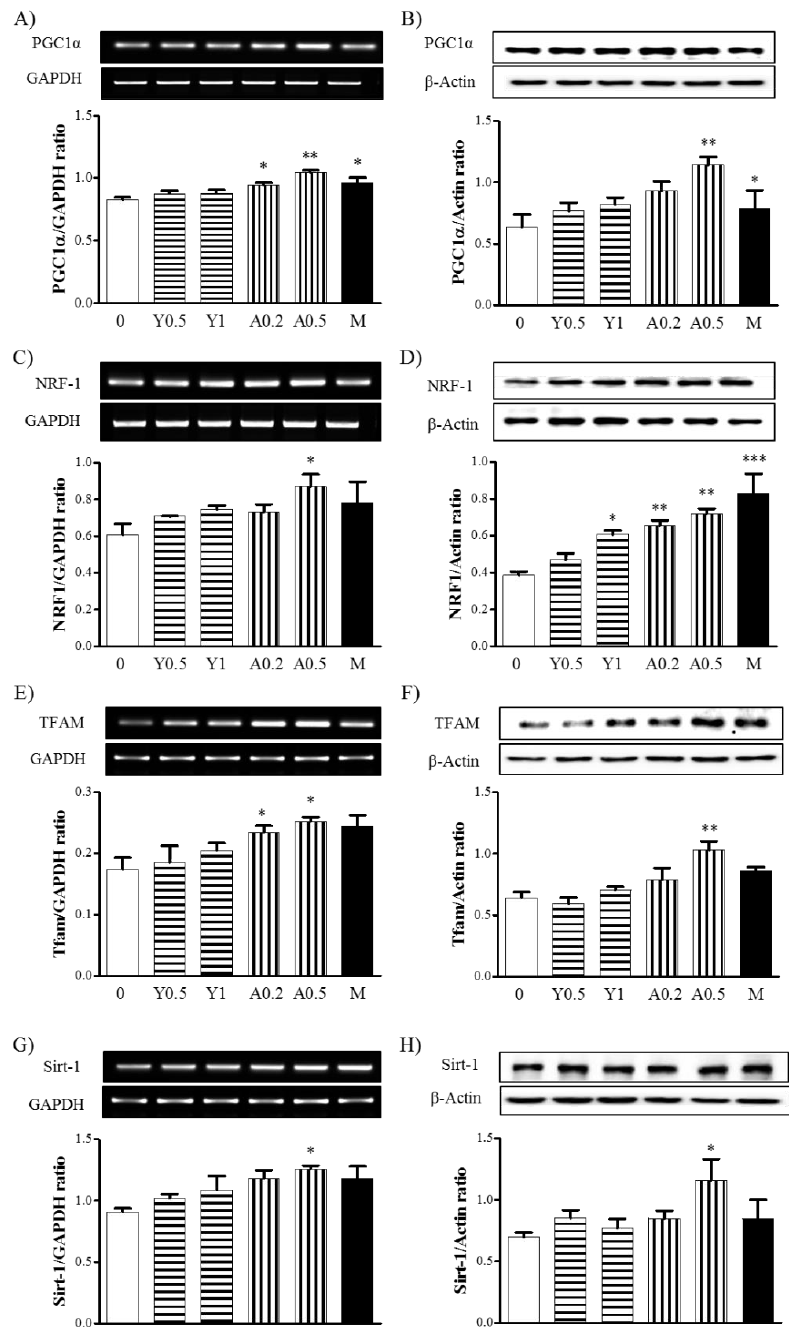
Figure 2. Effects of yam extract and allantoin on the expression of mitochondrial biogenesis-regulating factors in C2C12 myotubes. Differentiated myotubes were treated with or without yam extract (0.5 and 1.0 mg/mL) or allantoin (0.2 and 0.5 mM) for 24 h, after which the expression of PGC1 α ( A , B ), NRF-1 ( C , D ), TFAM ( E , F ) and Sirt-1 ( G , H ) mRNA ( A , C , E , G ) and protein ( B , D , F , H ) was analyzed by RT-PCR ( A , C , E ) and western blot ( B , D , F ), respectively. Metformin (2.5 mM) was used as a positive control. GAPDH and β -actin were used as internal controls. Each band was presented as a representative figure and the histogram was calculated from the band density value of each experiment. All data were presented as the means ± SEM of three independent experiments. Y, yam extract; A, allantoin; and M, metformin. * p < 0.05, ** p < 0.01 and *** p < 0.001 vs. non-treated negative control.